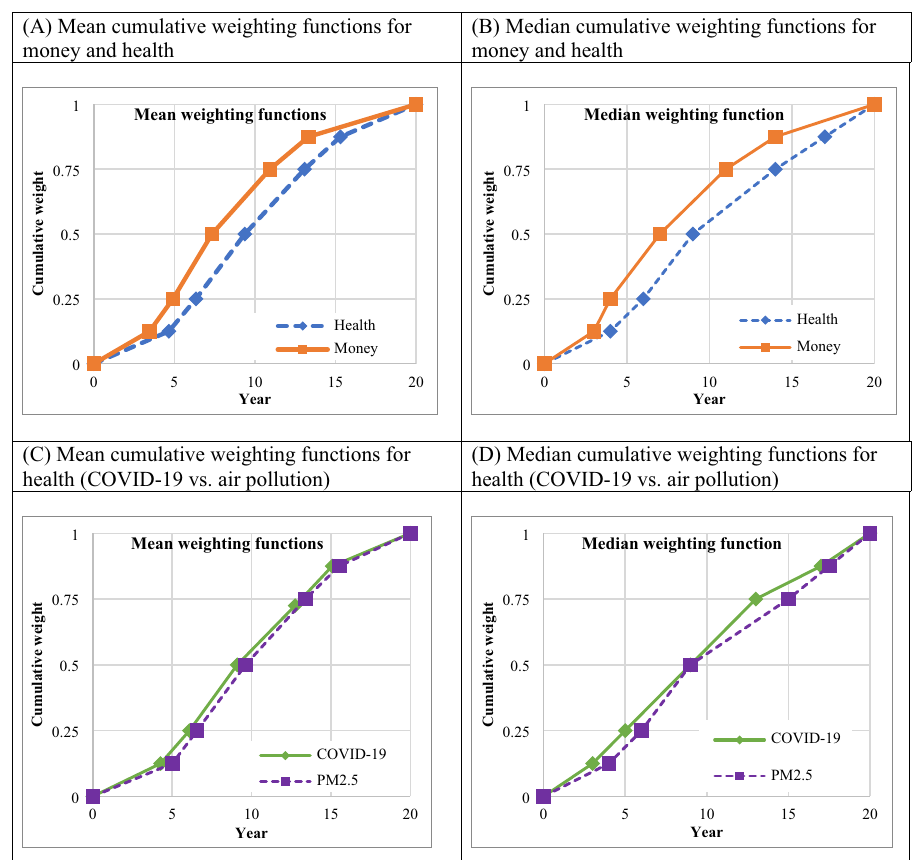
Figure 2. Cumulative weighting functions. COVID-19, Coronavirus disease 2019; PM2.5, Air pollution with fine particulate